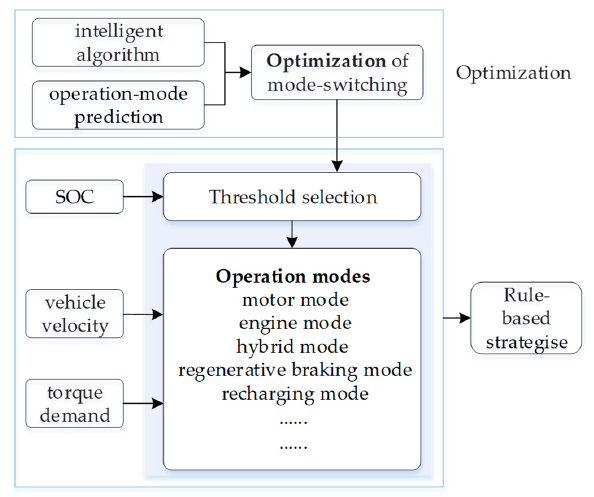
Figure 2. Depiction of the main research areas for rule-based strategies.